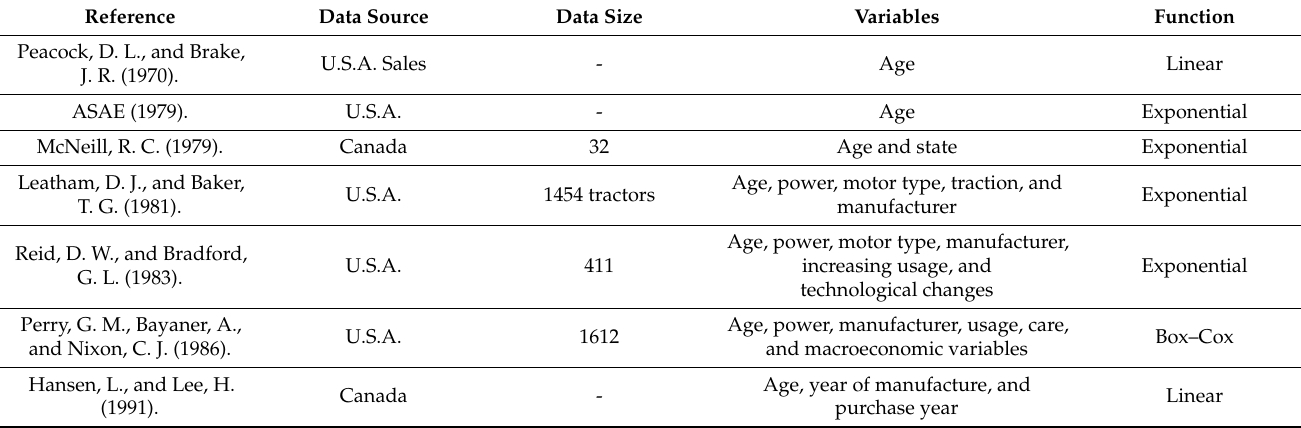
Table 1. Details of previous